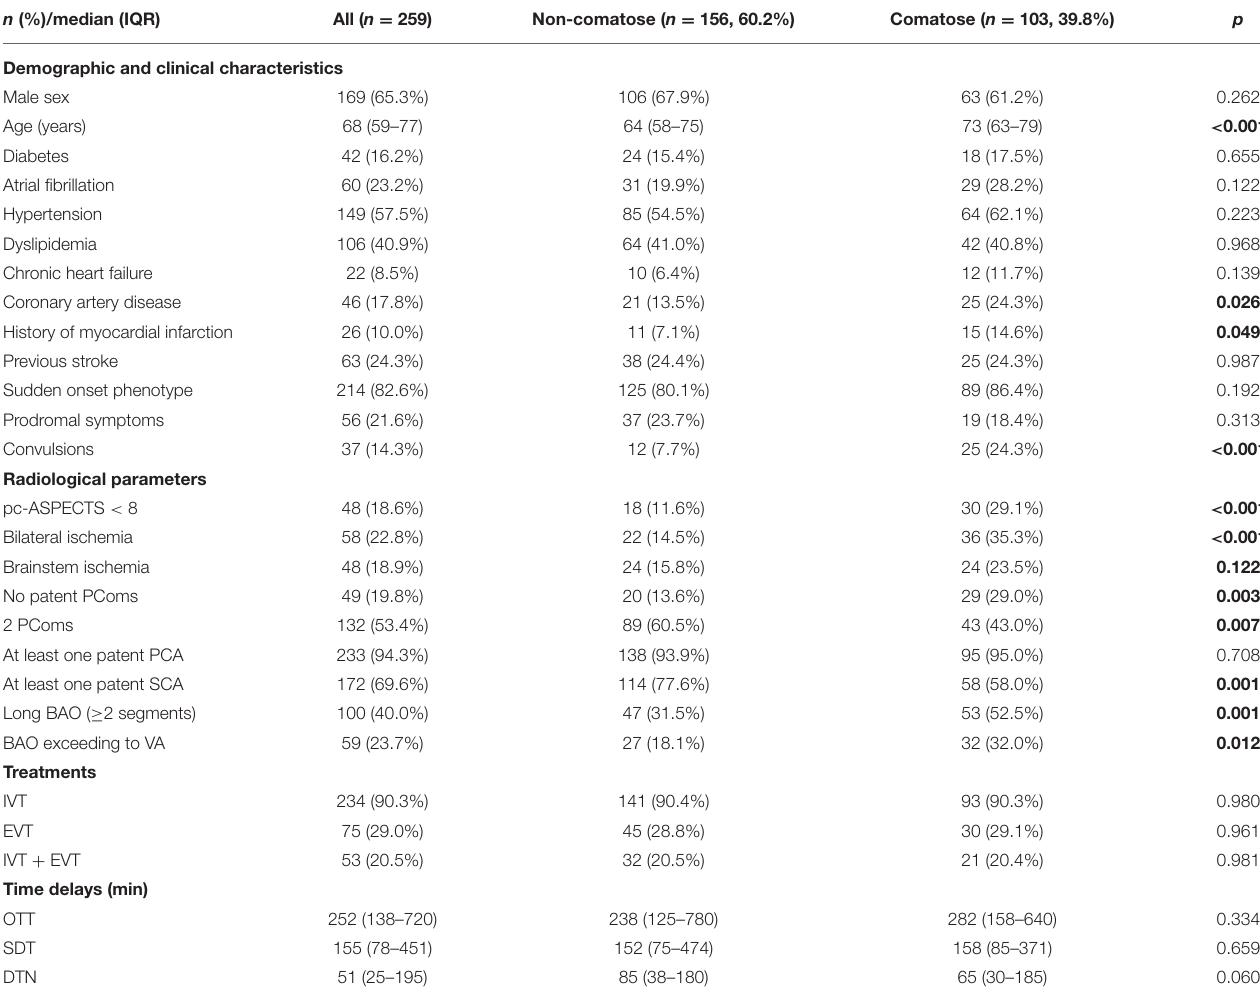
TABLE 1 | Characteristics of comatose vs. non-comatose patients at presentation. n (%)/median